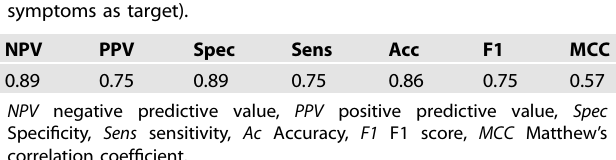
correlation coef fi